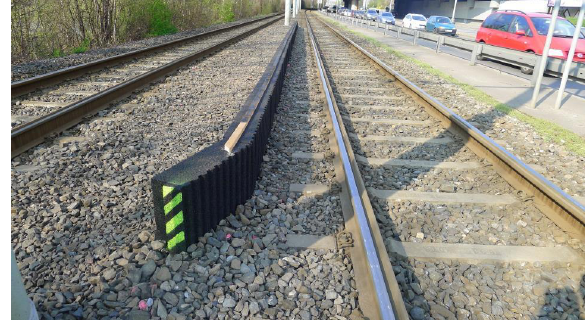
Figure 8. MNAS seen from the start of the section – chamfered first unit is evident in the front.